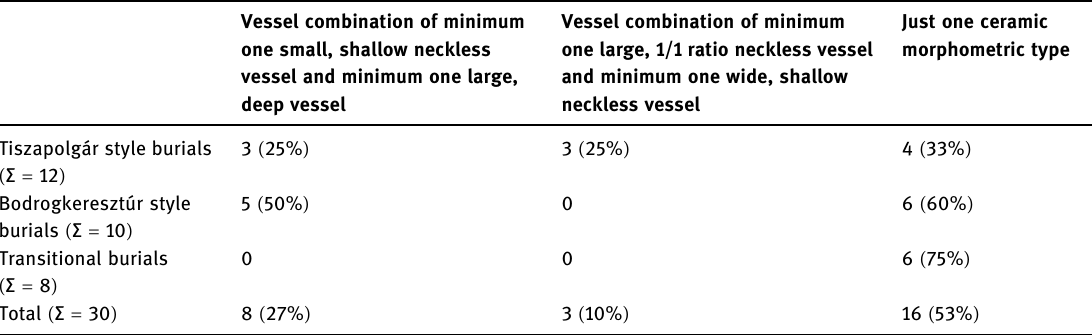
Table 3: The vessel combinations in graves which did not contain minimum one small, shallow neckless vessel and minimum one regular - sized vessel with neck at Tiszapolgár - Basatanya Vessel combination of